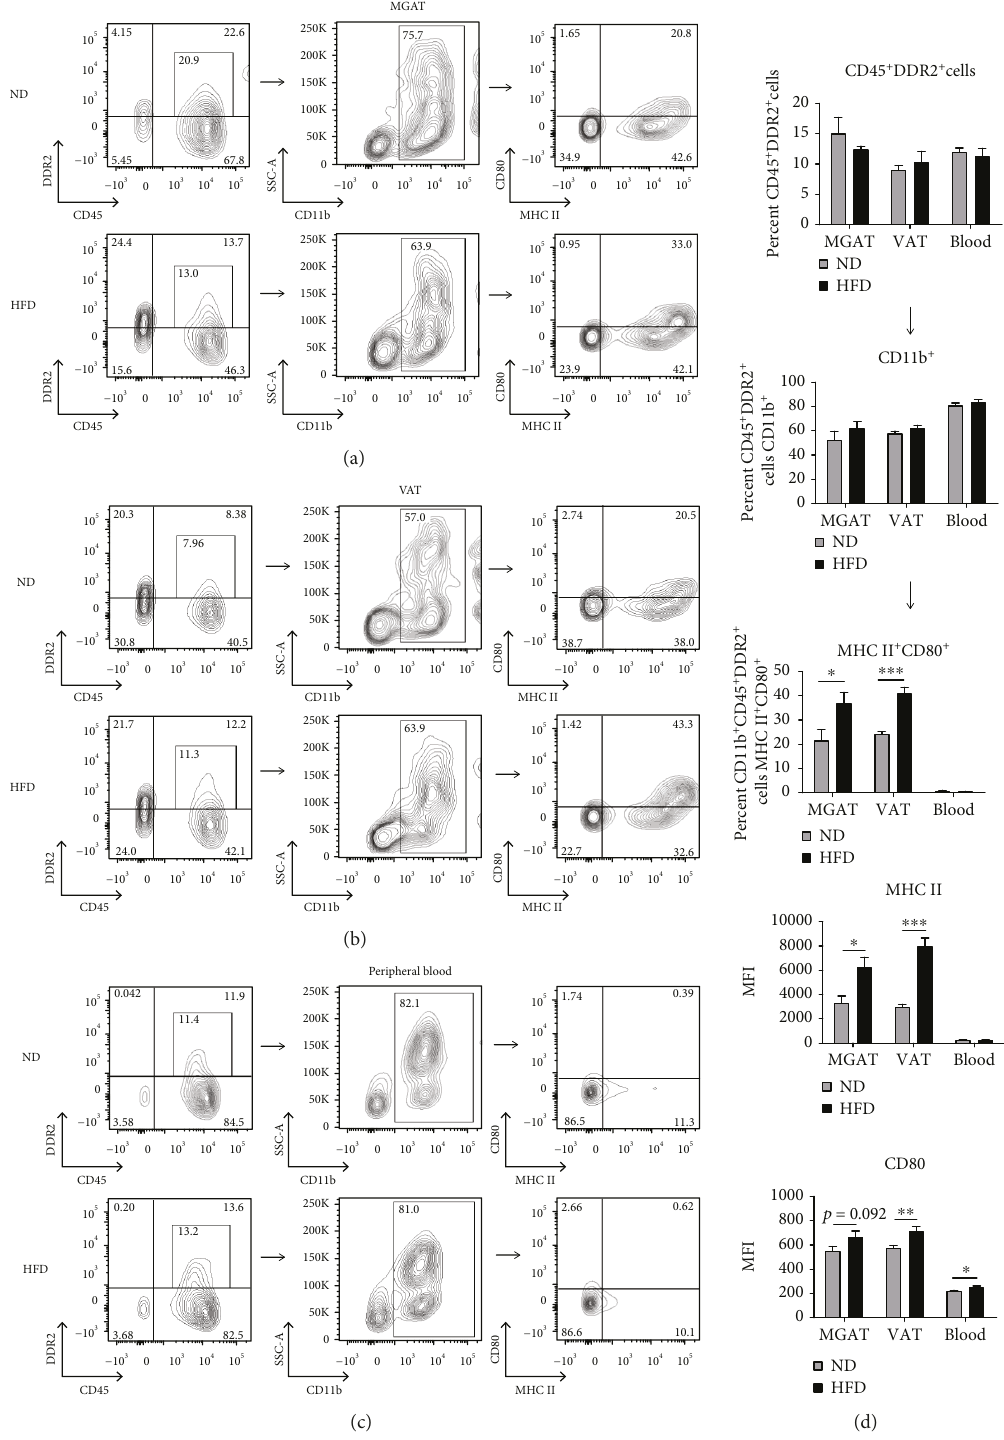
Figure 2: Increased percentage of myeloid-derived CD45 + DDR2 + cells express MHC II and CD80 in mammary gland-associated adipose tissue (MGAT) and visceral adipose tissue (VAT) of preobese mice compared to myeloid-derived CD45 + DDR2 + cells in MGAT and VAT of lean control mice. (a – c) Flow cytometric analysis of a representative mouse from each group, showing MHC II and CD80 expression in CD11b-expressing CD45 + DDR2 + cells from MGAT, VAT, and peripheral blood (PB) of HFD- and ND-fed C57BL/6 mice at endpoint (9 weeks of postinitiation of diet). For fl ow cytometric analysis, cells were fi rst gated on single, live cell populations. (d) Graphical representation of fl ow cytometric analysis, showing the percentage of total CD45 + DDR2 + cells, CD11b-expressing CD45 + DDR2 + cells, and MHC II and CD80 expression on CD11b-expressing CD45 + DDR2 + cells in MGAT, VAT, and PB of HFD- vs. ND-fed C57BL/6 mice. Data are presented as mean ± SEM of 5 mice per group. ∗ p < 0 05 , ∗∗ p < 0 01 , and ∗∗∗ p < 0 001